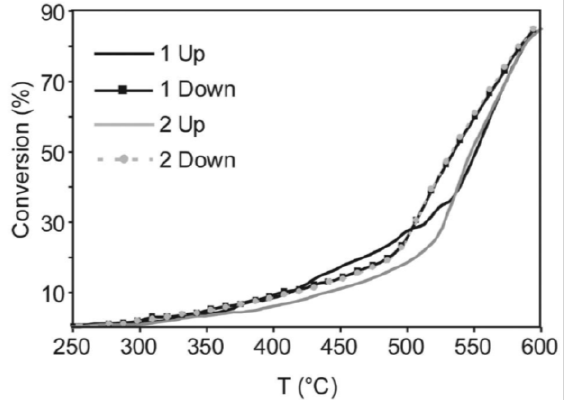
Figure 21. Methane conversion(activity) of highly porous and hierarchically ordered SiCN ceramics that integrate well-dispersed Pt nanoparticles as a function of the reaction temperature during two heating/cooling cycles (reprinted with permission from reference [151]; Copyright 2009 American Ceramic